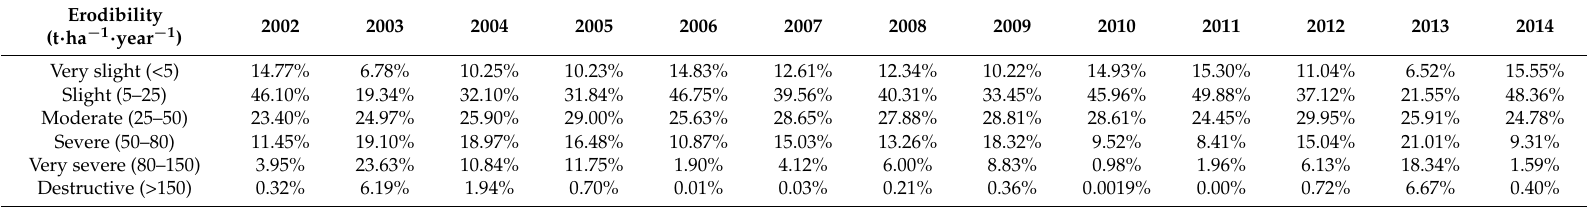
Table 3. The variations of the area ratio of each soil erosion intensity in the Wangjiagou agricultural watershed from 2002 to